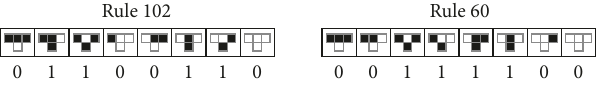
Figure 6: Rules 102 and 60 depicted in Wolfram’s notation.